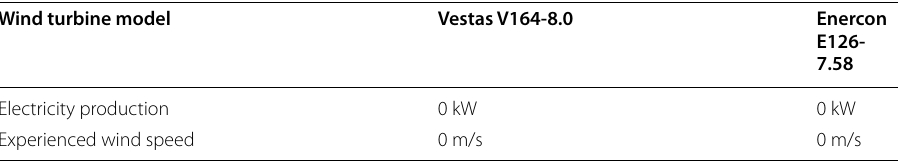
Table 2 Scenario 1 wind turbine results